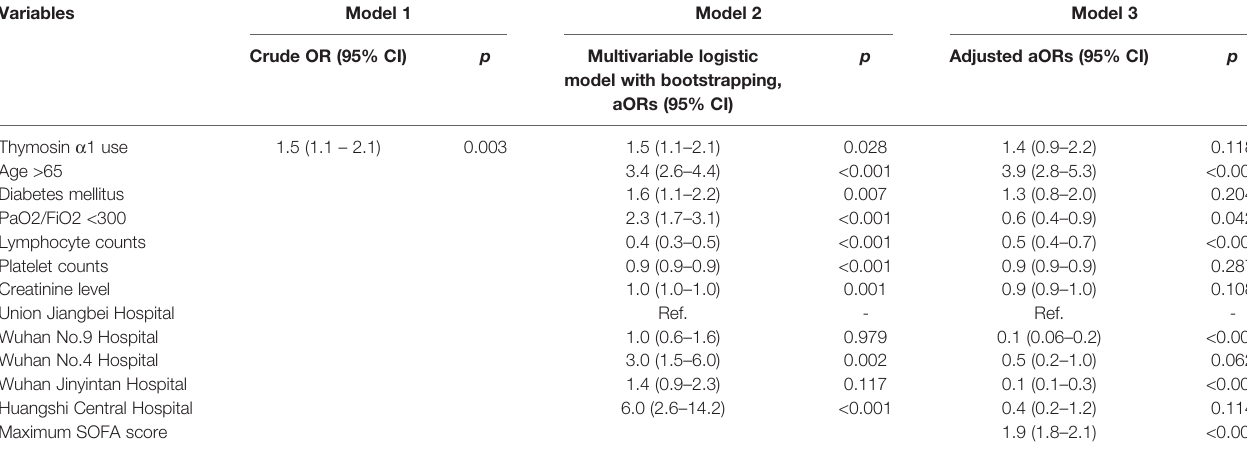
TABLE 3 | Associations between non-recovery rate and thymosin a 1 use in different logistic models.